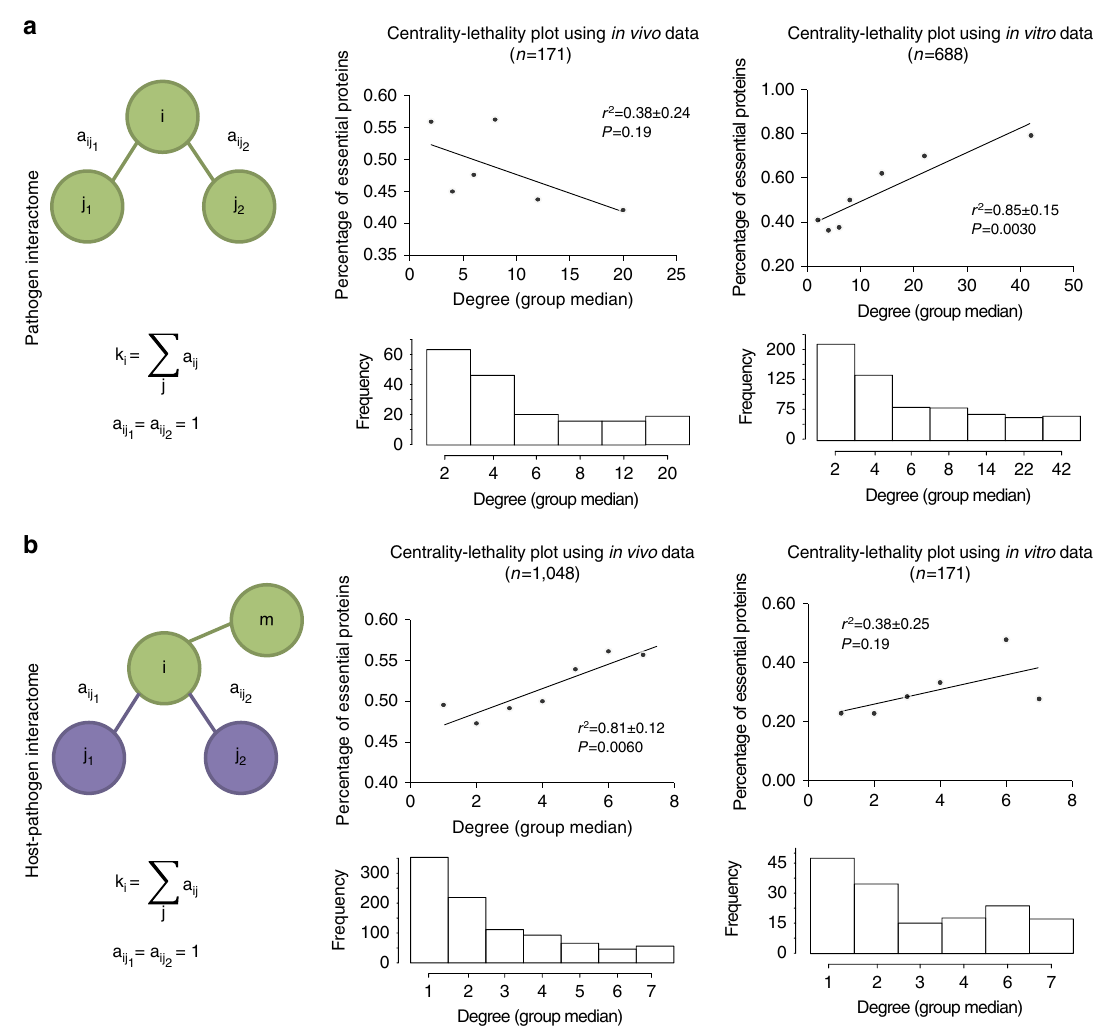
Figure 1 | Analysis of the centrality-lethality rule in Yersinia pestis. The percentage of essential proteins both in vivo (during infection) and in vitro (growth in culture medium) was plotted against its degree in ( a ) the pathogen (green) and ( b ) the host–pathogen interactome (purple). The total number of observations ( n ) is included in each graph ( n ¼ 1,048 for the Y. pestis interactome, n ¼ 688 for the H. sapiens–Y. pestis interactome and n ¼ 171 for proteins with data available in both interactomes). The degree ( k ) of a node i is defined as the number of edges linked to i as displayed in the figure. To control the effect size we grouped the data in bins according to degree to ensure a comparable number of observations in each bin. Histograms below each graph indicate the number of observations included in each bin. P -values were calculated using the t -test and the confidence interval for r 2 was estimated by bootstrapping before binning the data as detailed in the Methods